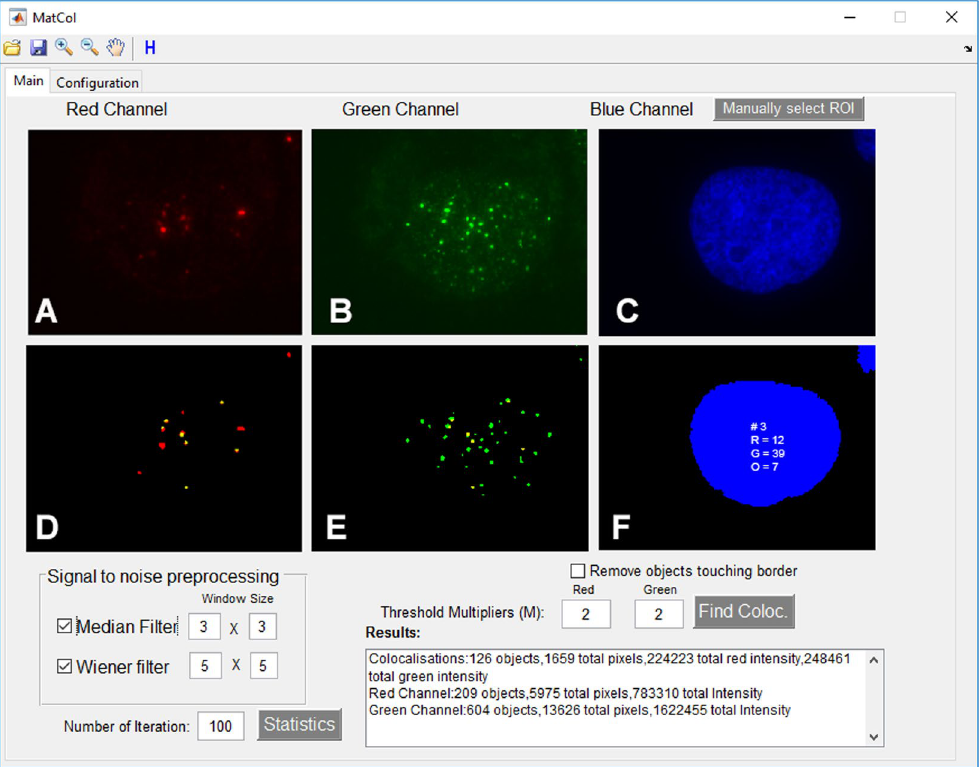
Figure 1. The MatCol graphical user interface (GUI). Six windows showing the red ( A ), green ( B ), and blue ( C ) channels in a single nucleus, along with their respective binary versions after removing the background ( D , E , F ). The screen shot has been zoomed to better display colocalised objects in the ROIs. Colocalisations of the two channels are shown in yellow in windows D and E. The coded ROI binary mask ( F ) enumerates the ROI sequence number (#), the red (“R”) and green (“G”) signals, as well as their overlap (“O”) in this single nucleus. The Results panel describes the features of the entire image, which has numerous ROIs. The remaining MatCol features in the GUI are described in the Results section. The entire image from which A–F was taken is shown in Supplementary Figure